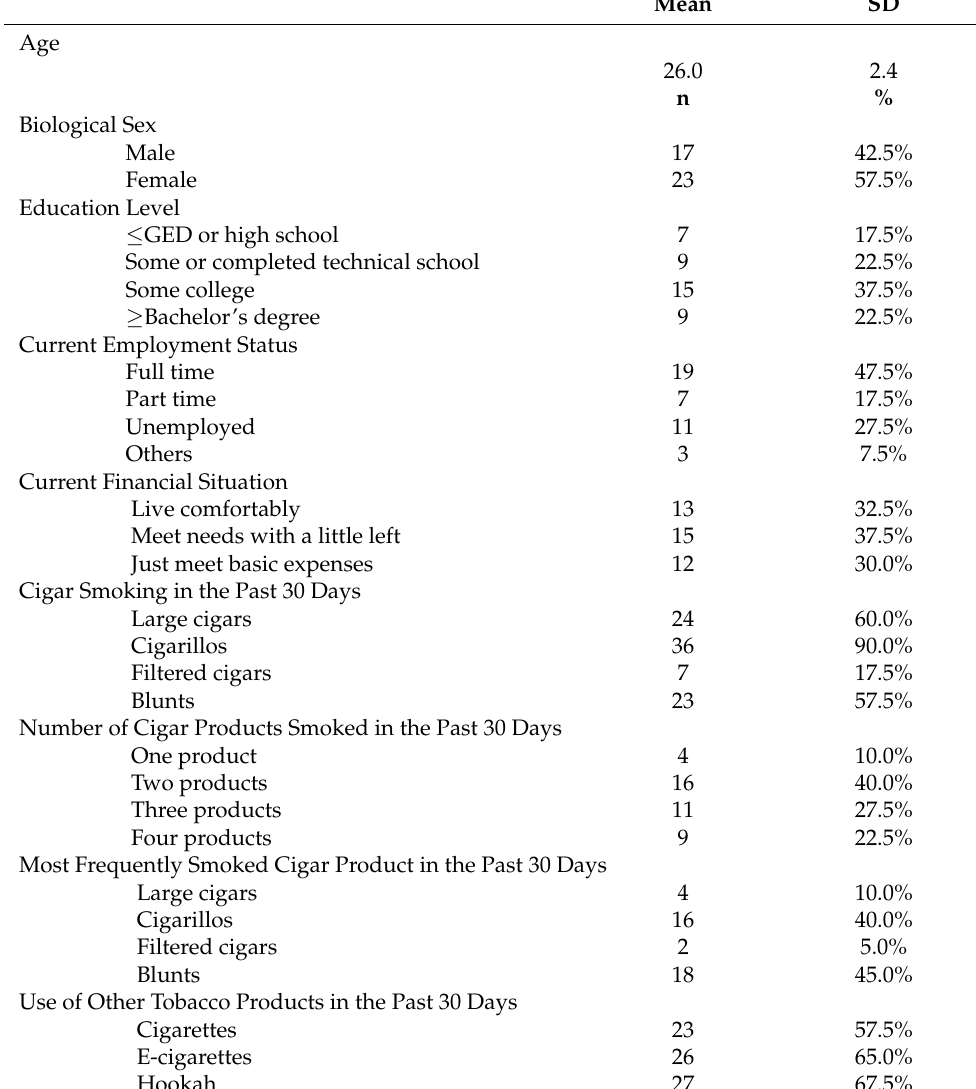
Table 1. Participant characteristics (n =